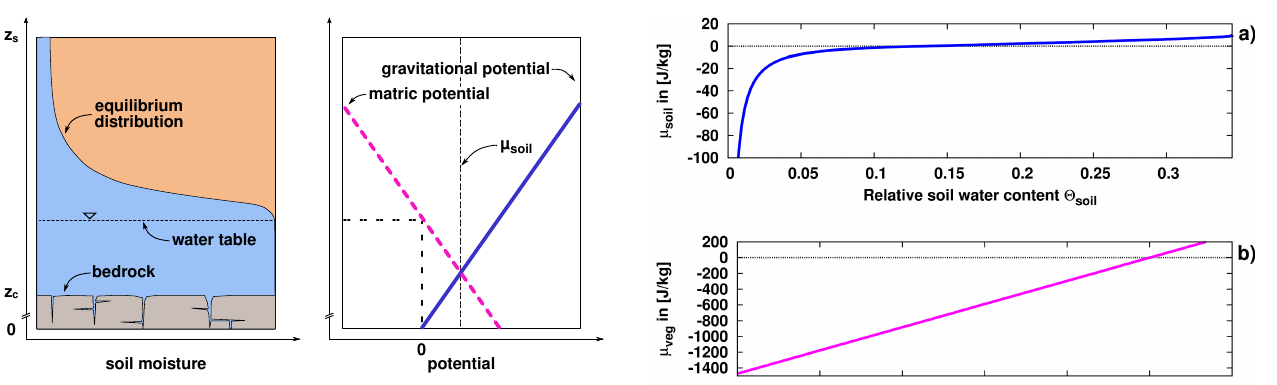
Fig. 23. Left: Equilibrium distribution of soil water inside the Fig. 2. Left: equilibrium distribution of soil water inside the bucket, bucket, z s and z c correspond to the height of the surface and the z s and z c correspond to the height of the surface and the channel, channel, respectively. Right: Soil water potential µ soil as a function respectively. Right: soil water potential µ soil as a function of height. of height.